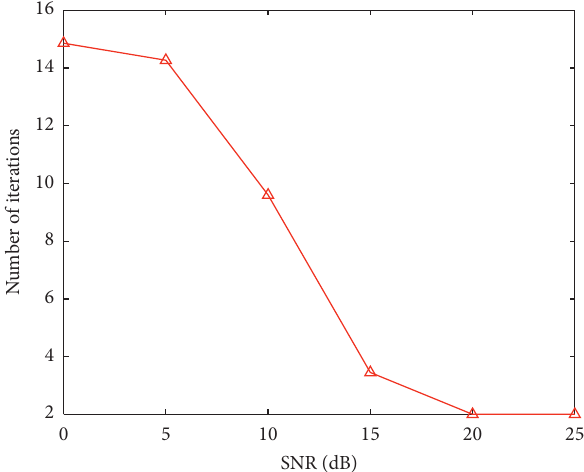
Figure 6: Average number of iterations curves versus